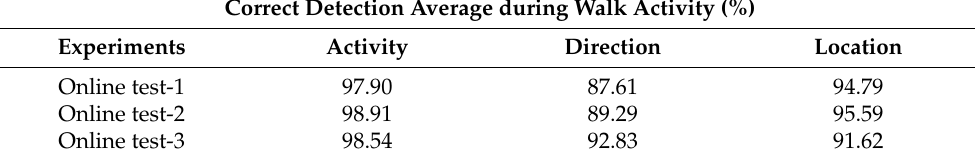
Table 7. Average of correct detections for each task during walk activity based on data from all three online test series.